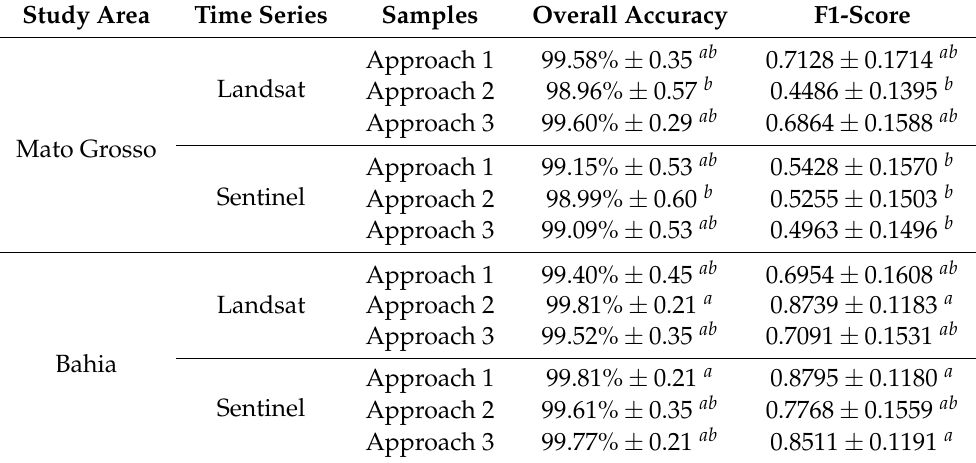
Table 5. Overall Accuracies for the maps and F1-Scores for their deforestation class. The exponent letters represent the groups in which the Overall Accuracies or F1-Scores are statistically the same. Group a comprises the highest values and group b the